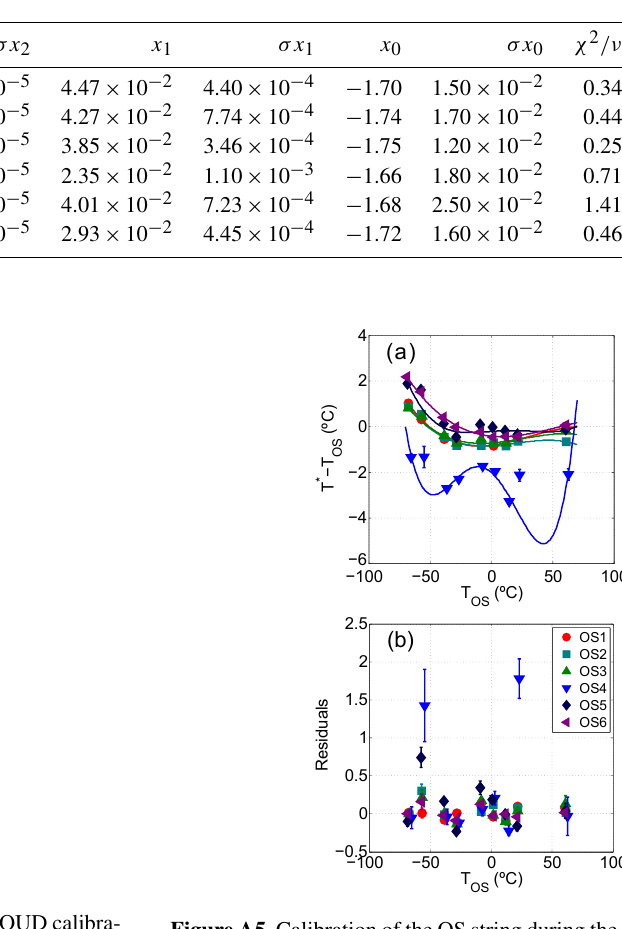
Table A2. Fitted calibration parameters and 1 standard deviation uncertainties for the thermocouple string obtained during the CLOUD calibration campaign.